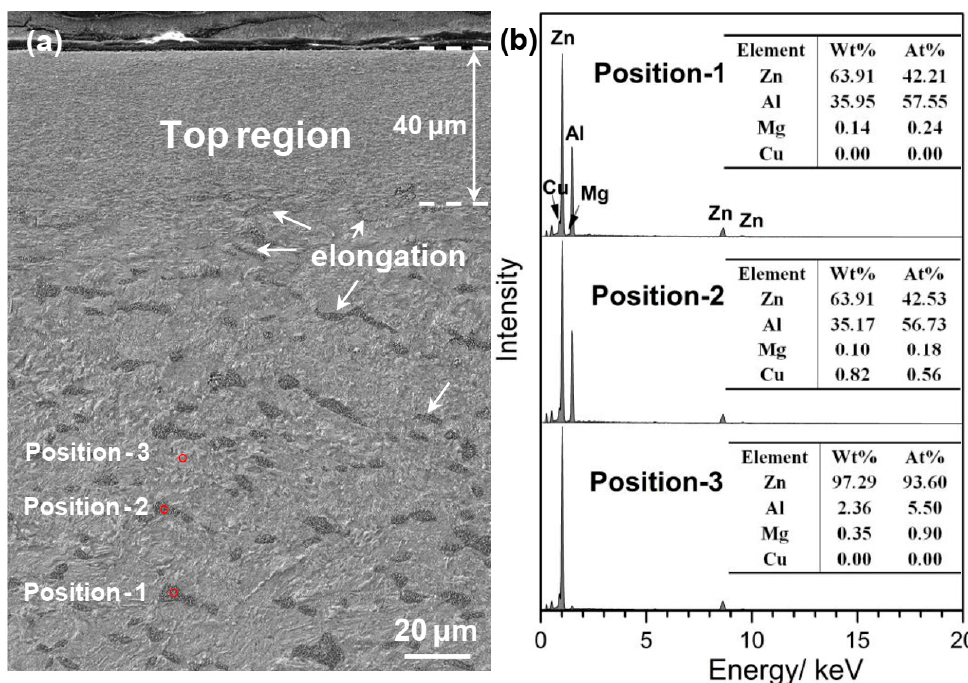
Figure 2. SEM micrograph of the top region in the SFT sample ( a ) and EDS analysis results ( b ).